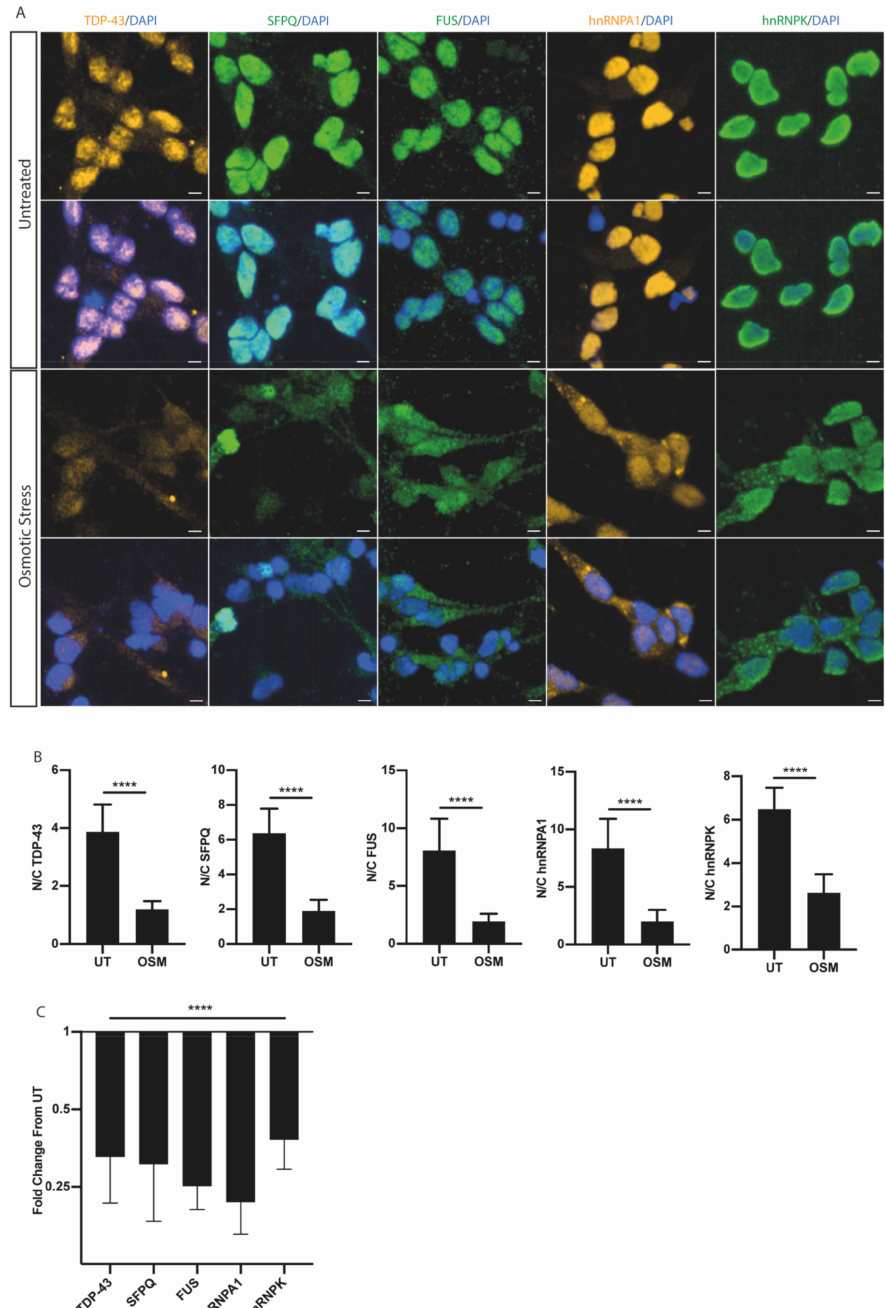
Figure 2. Osmotic stress causes unique changes in the nucleocytoplasmic distributions of ALS-linked RBPs. ( A ) Representative images of TDP-43, SFPQ, FUS, hnRNPA1 and hnRNPK in human motor neurons either untreated or treated with 0.4 M sorbitol treatment for 1 h to induce osmotic stress. Scale bars = 5 µ m. ( B ) Quantification of the nuclear / cytoplasmic average intensity ratio for TDP-43, SFPQ, FUS, hnRNPA1 and hnRNPK in untreated (UT) conditions and upon osmotic stress (OSM) show a reduction in the nuclear / cytoplasmic ratio for each RBP upon osmotic stress. Data shown are mean nuclear / cytoplasmic ratios ( ± SD) per well, calculated from > 10,000 cells from 3 control lines in 3 independent experimental repeats as a minimum. p -value from unpaired t -test; **** = p < 0.0001. ( C ) The fold change in the nucleocytoplasmic ratio was calculated upon osmotic stress for each ALS-linked RBP. Data are shown as mean fold change in comparison to untreated values in each experimental repeat. p -value is from a Brown–Forsythe ANOVA test; **** = p <